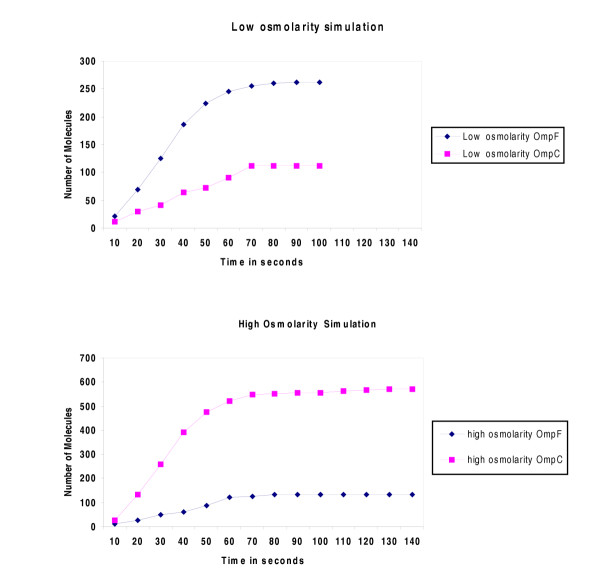
Porin production at Low and High osmolarity conditions Indicated in the X-axis is the time in seconds and number of molecules of the component in the osmoregulatory switch in Y-axis. (a) The start of simulation with OmpF (indicated in blue) synthesis gradually triggered. By mid term of simulation steady state production and final saturation of OmpF molecules could be seen. Shown in b is the OmpC (indicated in pink) production and reaching saturation levels at high osmolarity conditions.